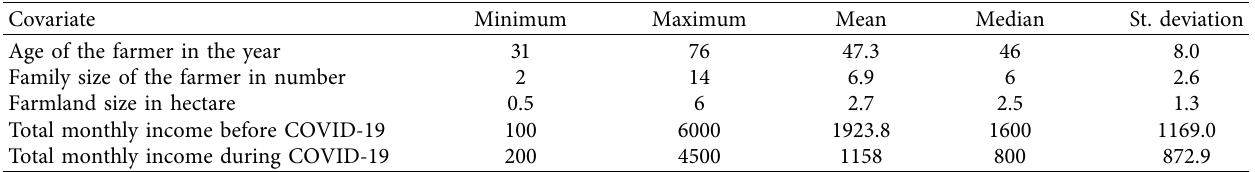
Table 4: Summary statistics for continuous covariates included in the